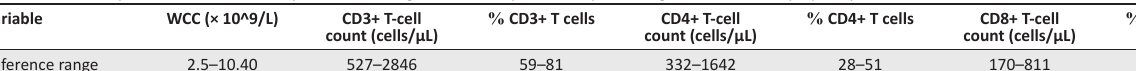
TABLE 5: Internally established laboratory reference ranges for leucocyte count, percentage and absolute lymphocyte subsets.